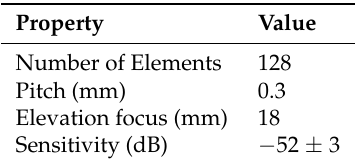
Table 2. Properties of the L 11 − 5 v Verasonics transducer.